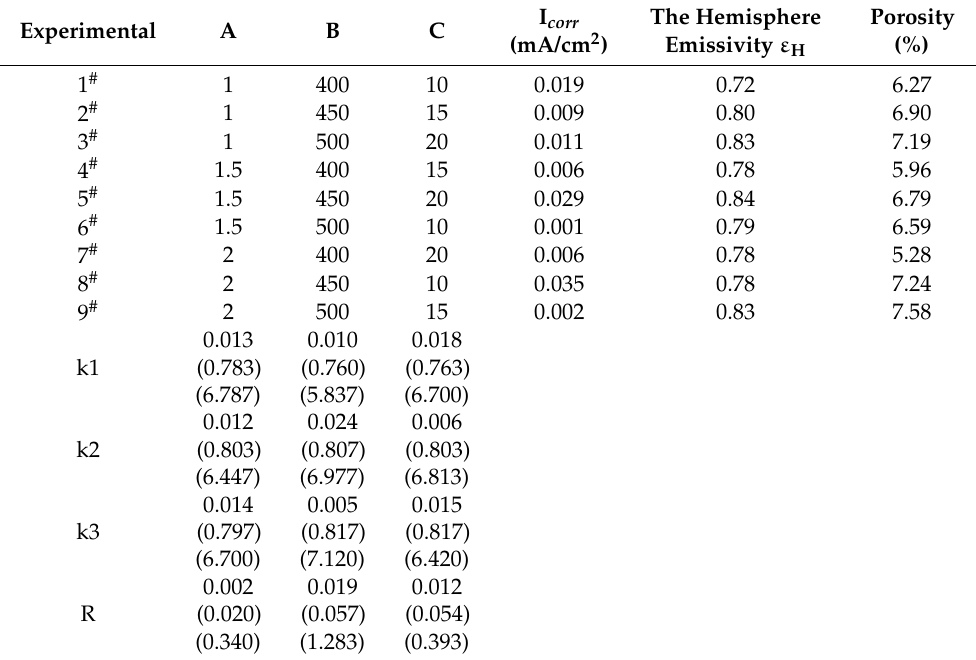
Table 2. Orthogonal experimental array and analysis of experimental